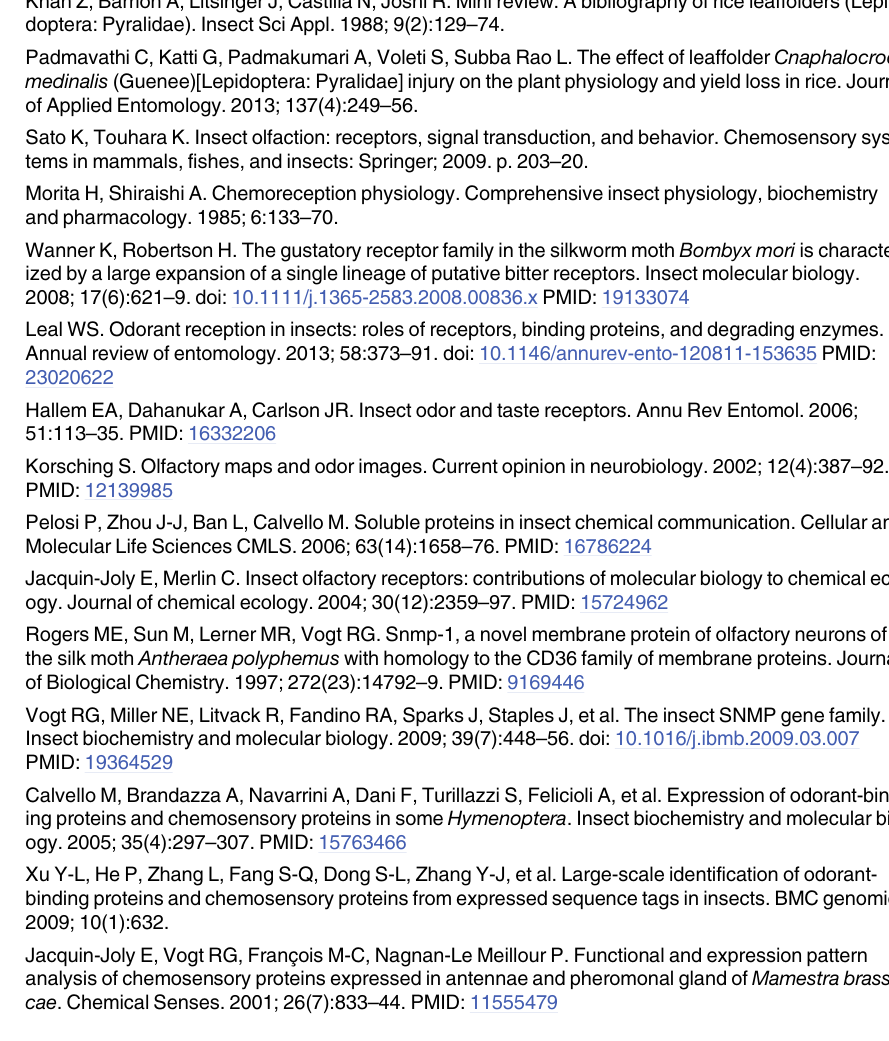
S1 Table. Primers used in the quantitative real-time PCR